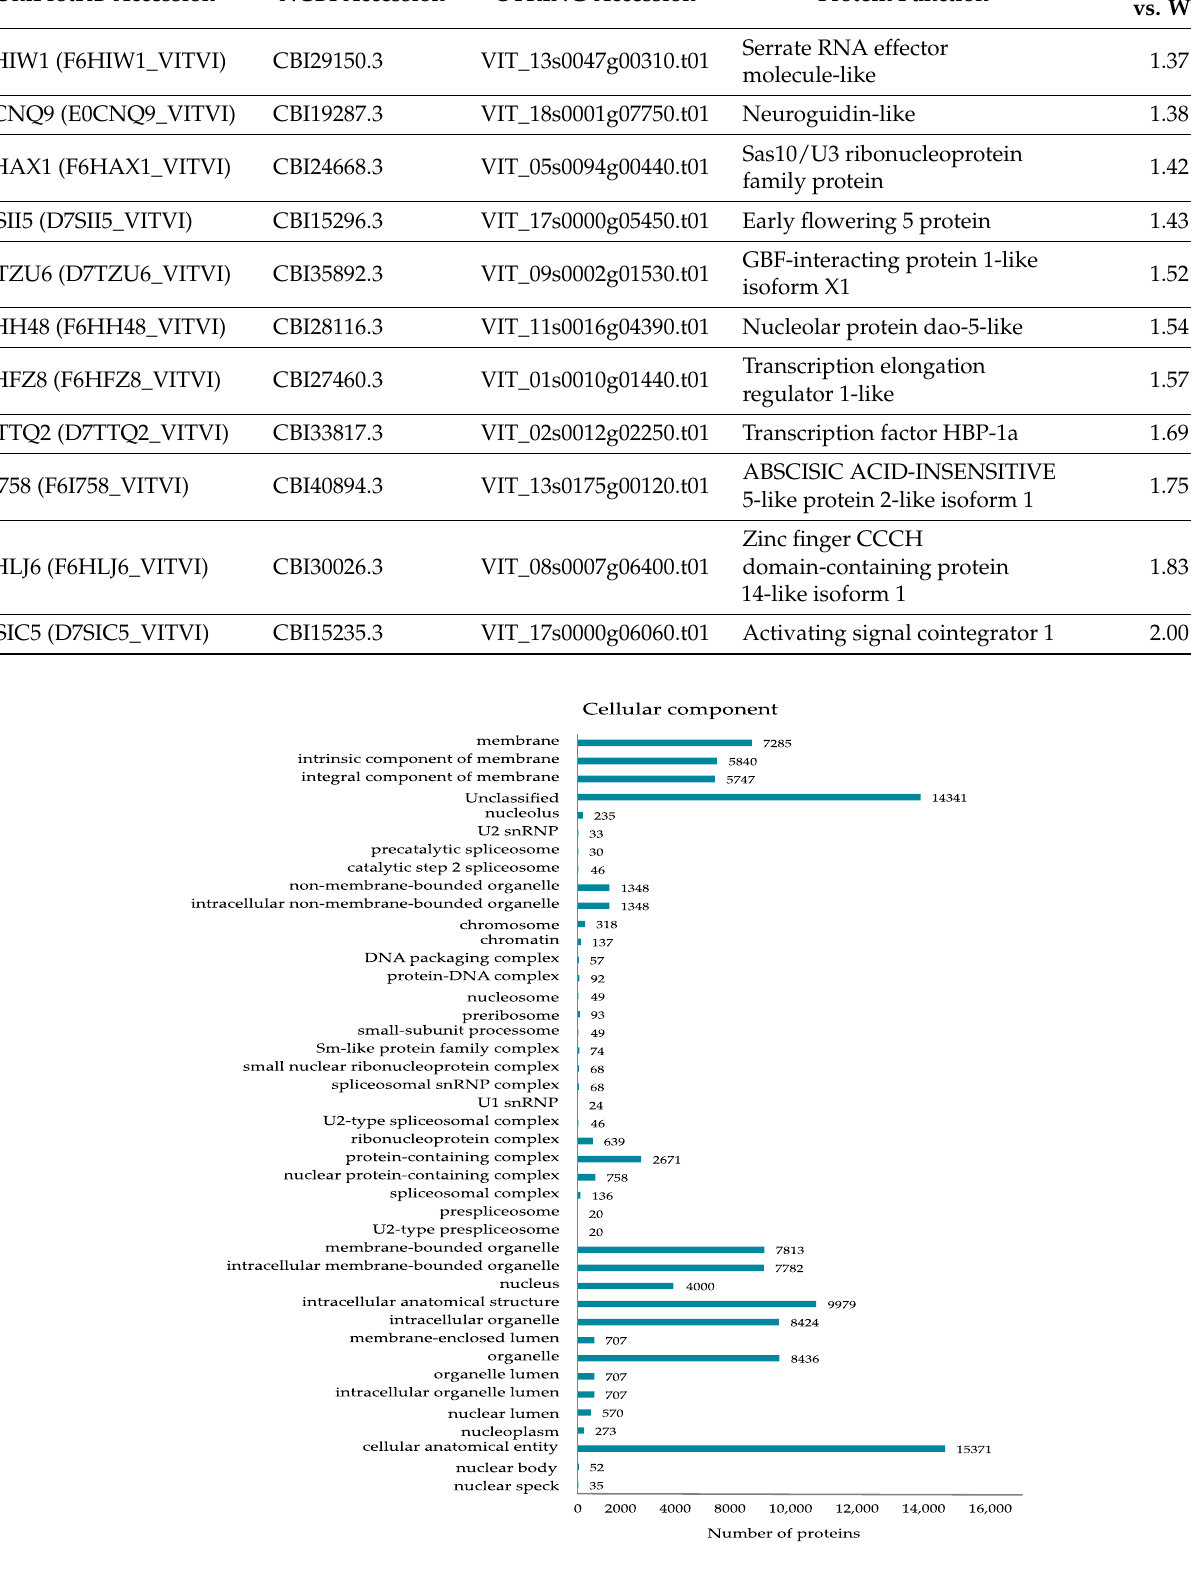
Figure 2. GO classification of the DEPs by localization as cellular components.